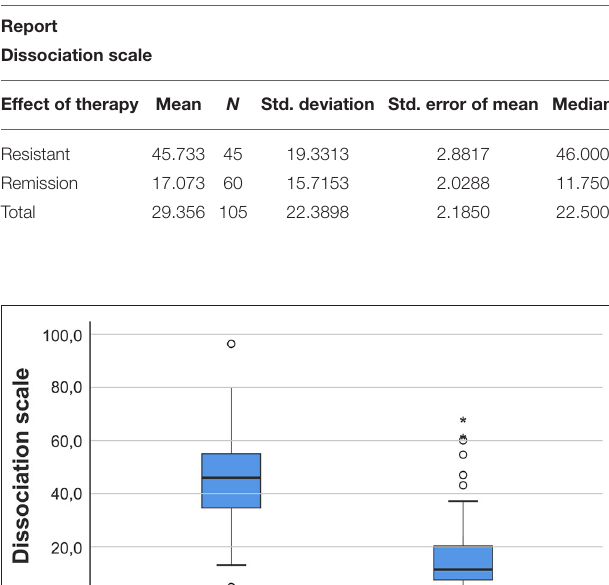
TABLE 1 | Descriptive analysis, the mean values, the median value, the standard deviation, and the standard error in the sample.